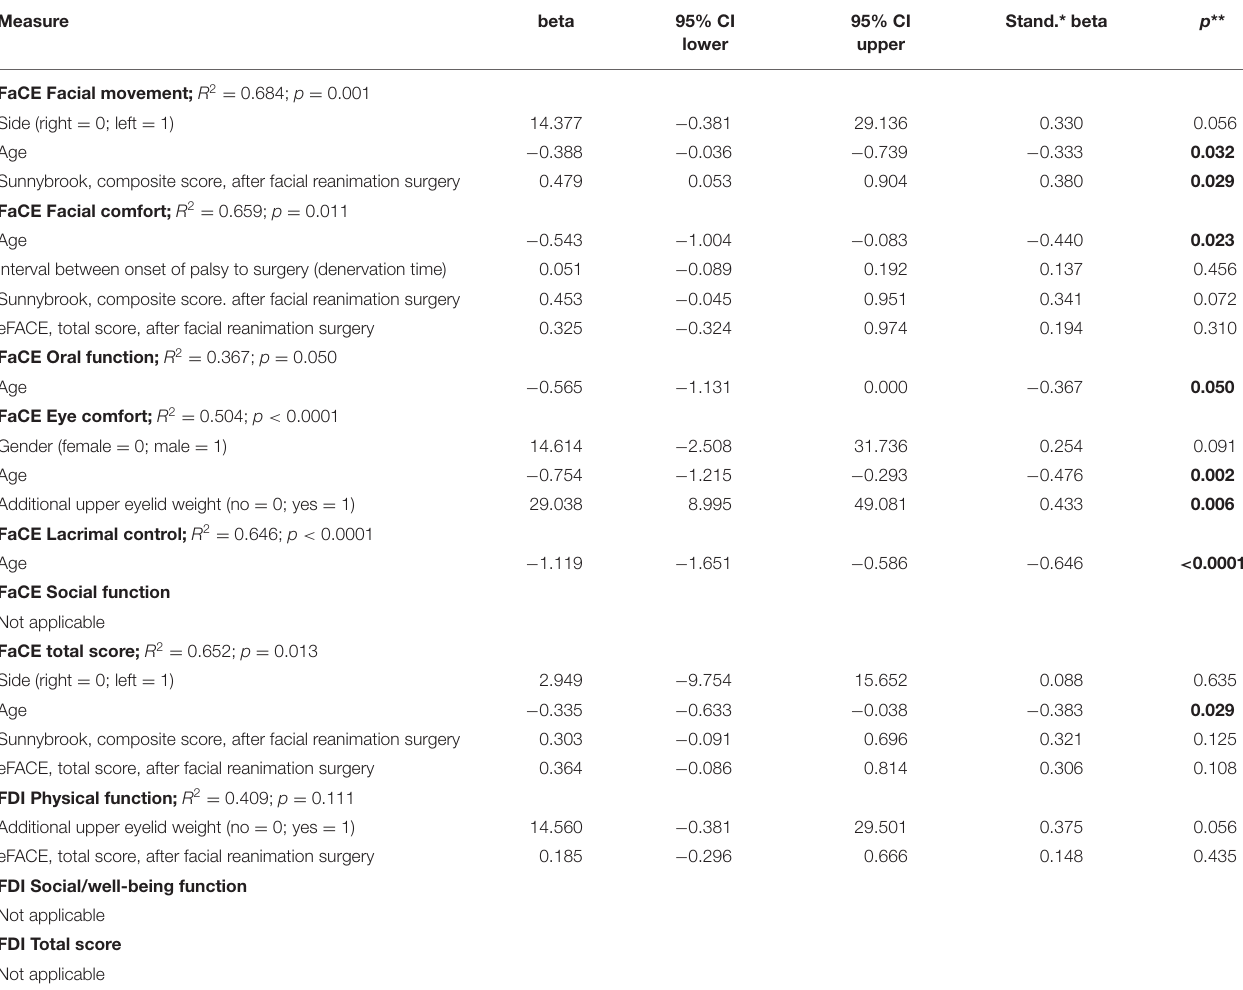
95% CI Stand.* beta p ** lower upper